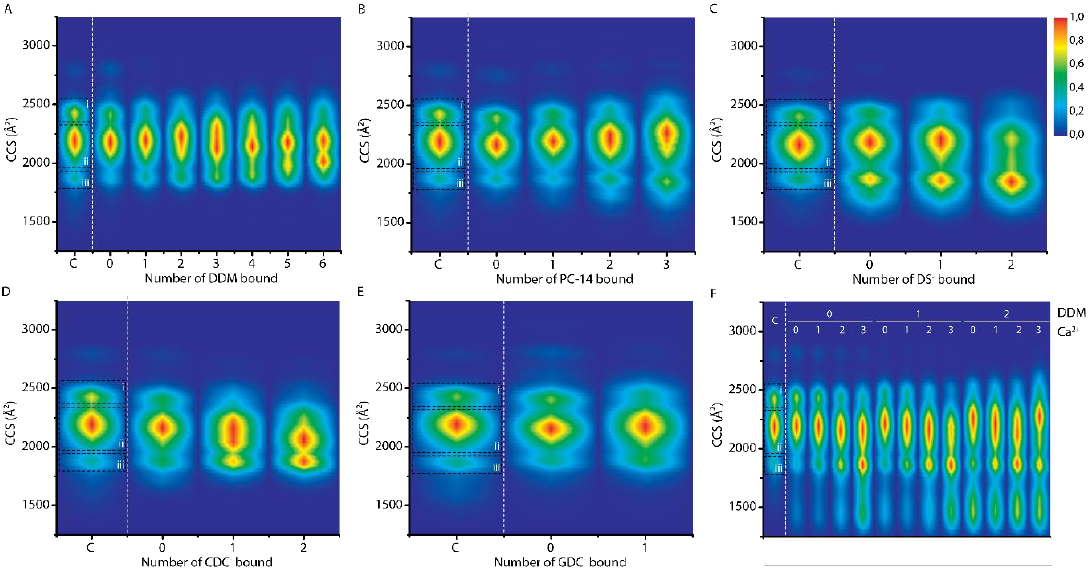
Figure 3. ( A – E ) CCS plots showing the conformational effects per additional detergent molecule interacting with the 7+ charge state of α-syn. On the x-axis “C” indicates the control, the unbound state of the 7+ charge state of α-syn without detergent present. “0” indicates the unbound state of the 7+ charge state of α-syn with detergent present (detergent concentrations used: 2× CMC DDM and PC-14, 0.02× CMC SDS, 0.2× CMC SCDC and SGDC). ( F ) CCS plot when 2× CMC DDM and 400 µM CaCl 2 is present. Intensities are scaled as described in the method section.